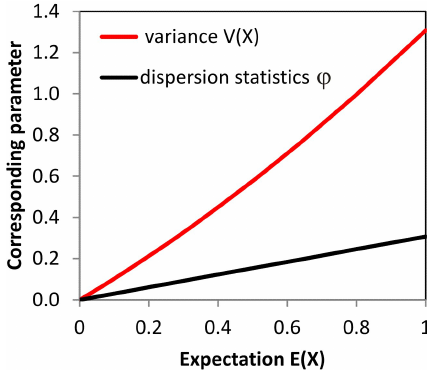
Figure 2. Estimated distributions for the DWD sample with CRP =